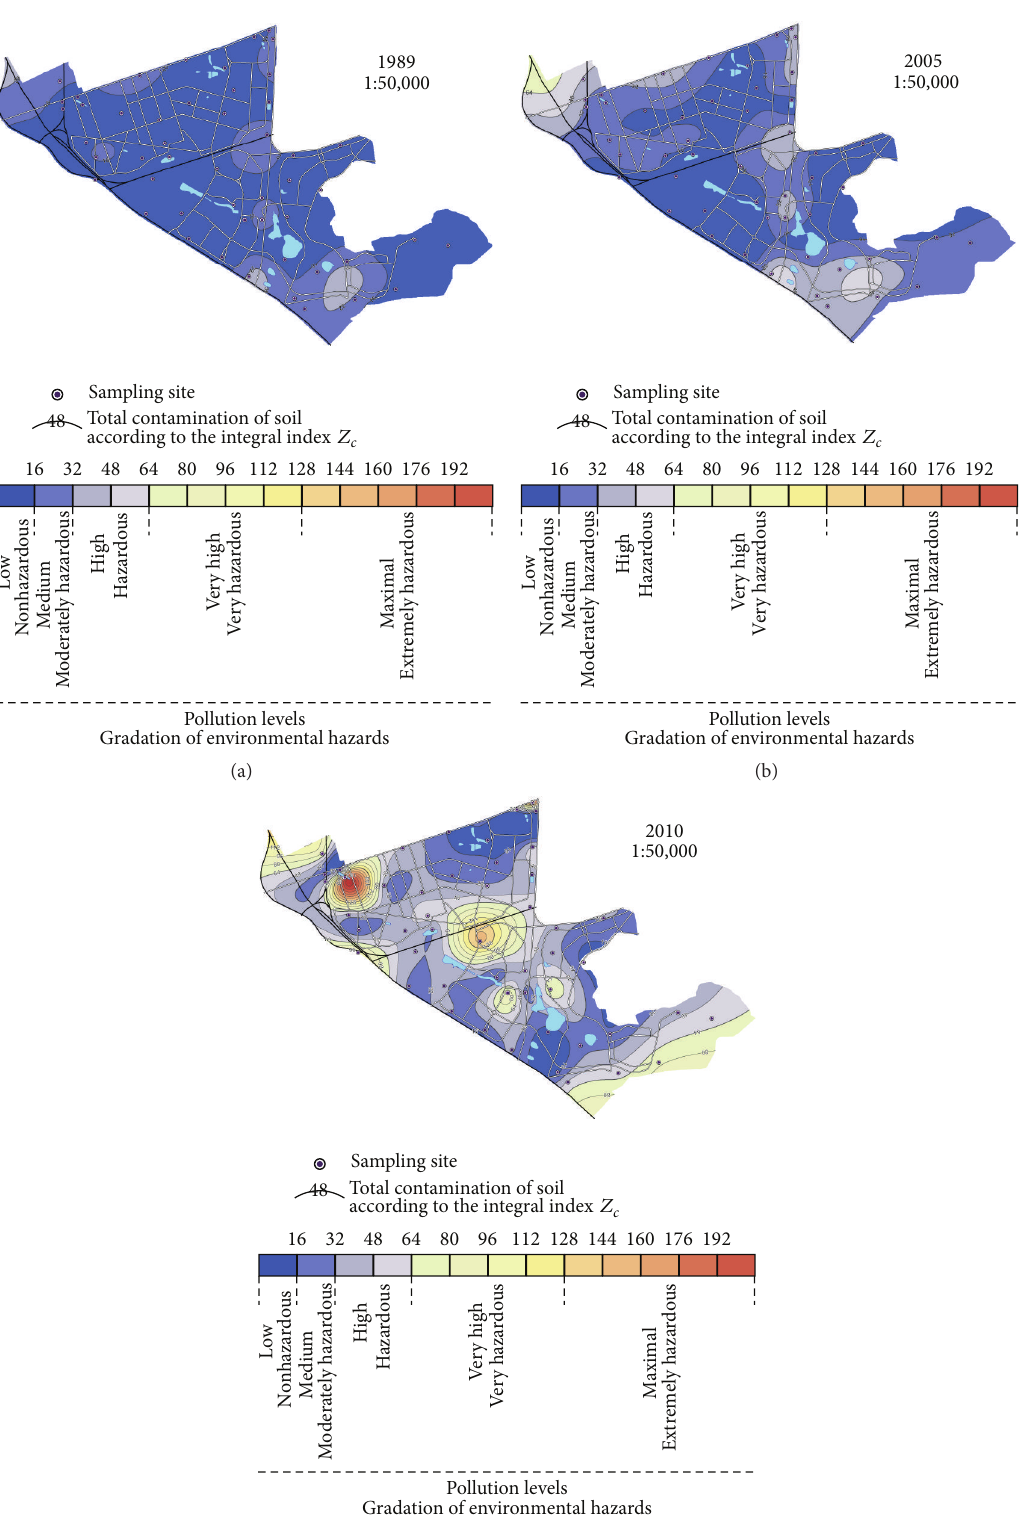
Figure 3: Total technogenic anomalies of HMs (according to 𝑍 𝑐 index) in topsoils of the Eastern district of Moscow in 1989, 2005, and